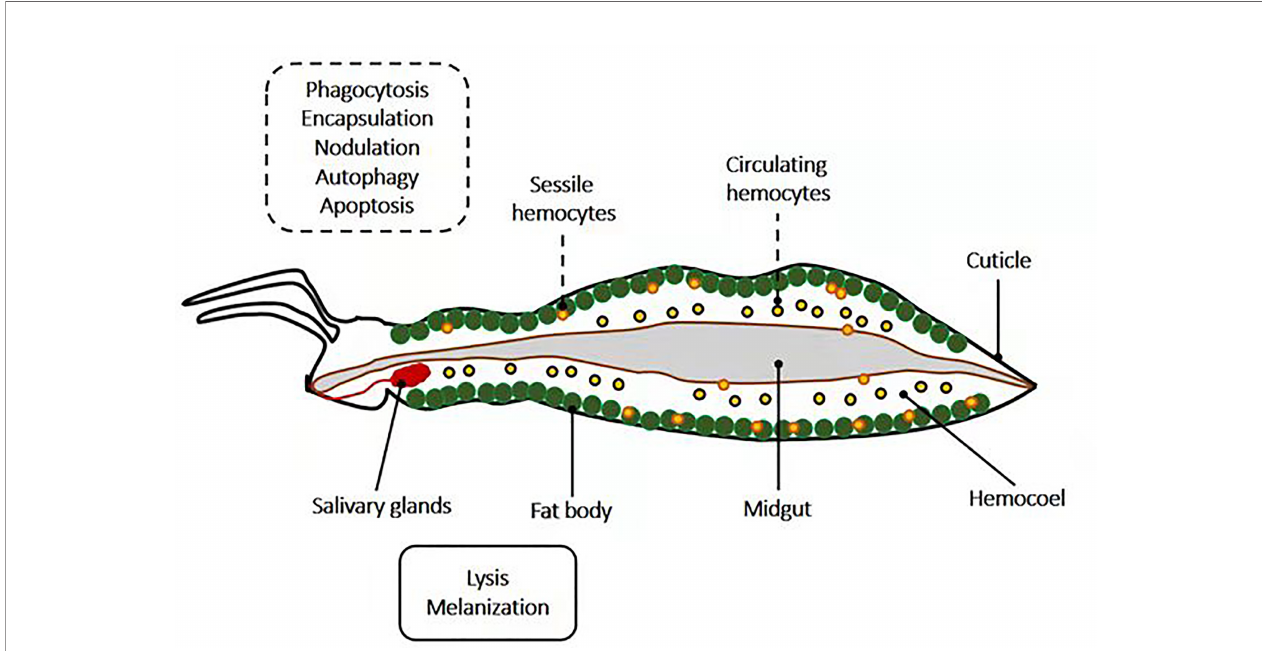
FIGURE 3 | Schematic representation of the localization of insects ’ immune effector mechanisms. Mechanisms such as phagocytosis, encapsulation, nodulation, autophagy, and apoptosis occur in insect hemocytes (sessile and circulating), which are located in the hemocoel. Meanwhile, insect parts such as salivary glands, the fat body, and midgut are potent sites for lysis and